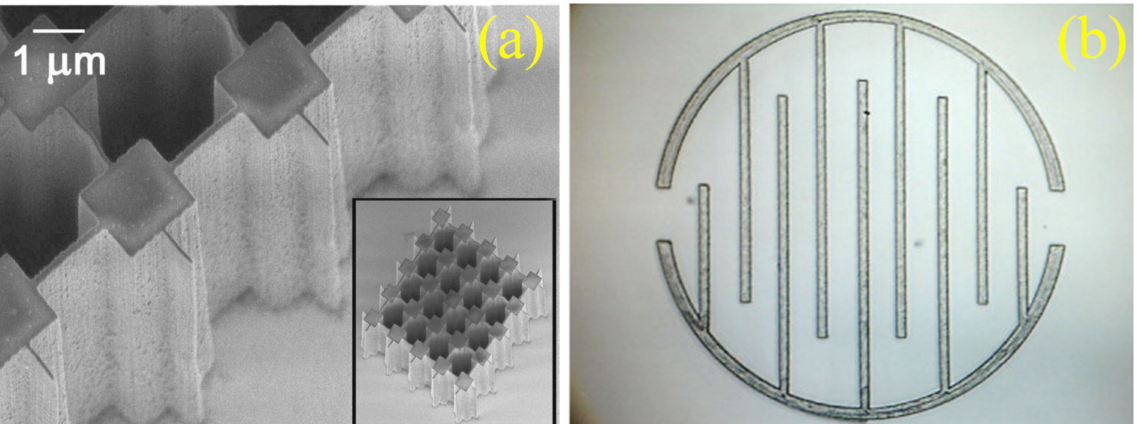
Figure 15. ( a ) Microscope of 2 × 2 µ m 2 pillars fabricated in SU8 negative resist using p-beam writing with energy of 1 MeV. Reprinted with permission from [146]. Copyright 2003 AIP Publishing. ( b ) Fabrication of micro walls in PDMS. Reprinted with permission from